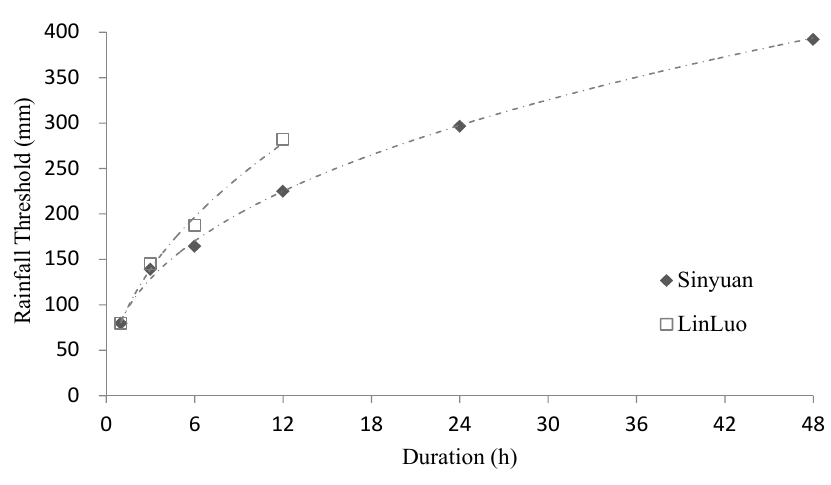
Figure 6. Relationship between rainfall durations and thresholds for Sinyuan and Donggang